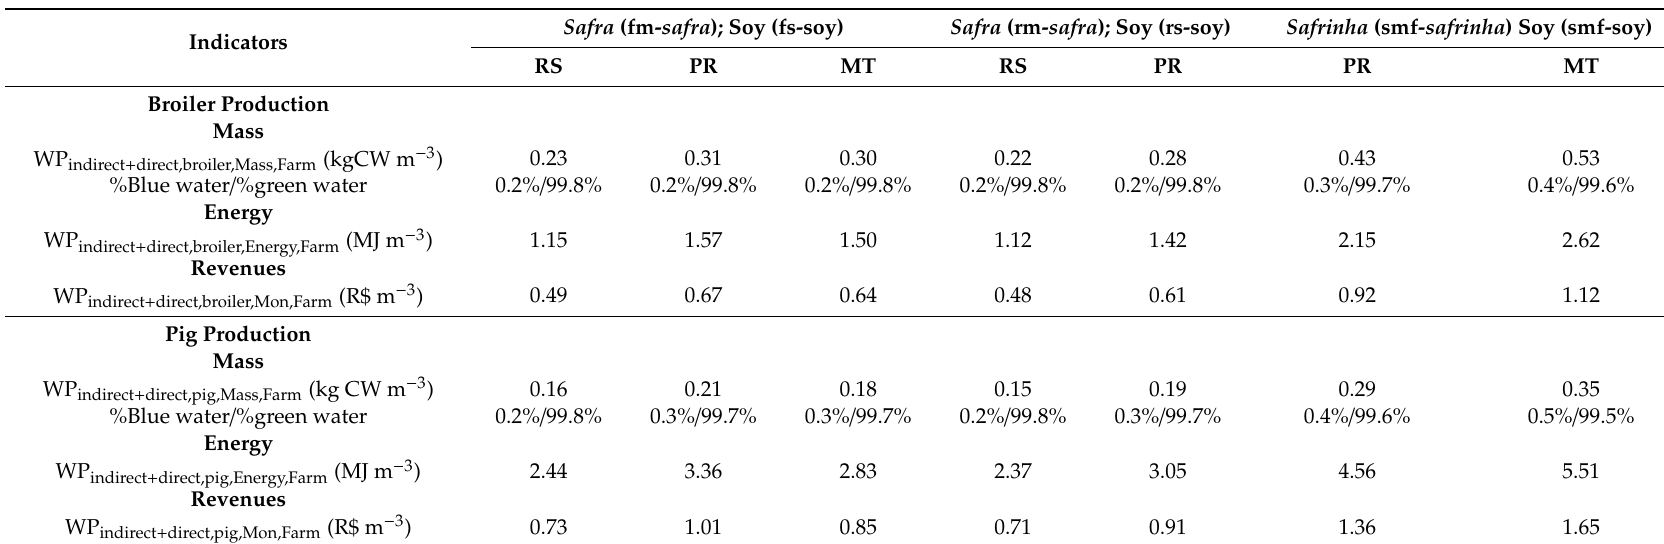
Table 6. Water productivity of broiler chicken production (WP indirect + direct,poultry,Farm ) in the farms investigated in the 1st scenario (CY). RS: Vacaria (city) located in Rio Grande do Sul State; PR: Cascavel (city) located in Paran á State; MT: Primavera do Leste (city) located in Mato Grosso State.